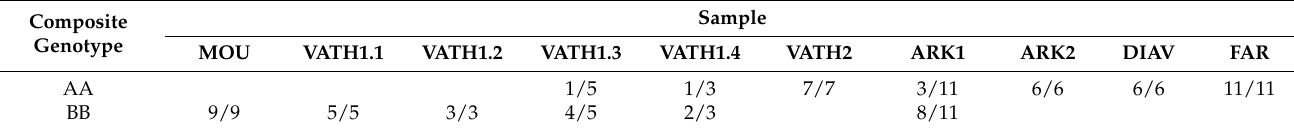
Table 3. Haplotypes (composite genotypes) and haplotype frequencies of the examined samples as revealed by RFLPs. Composite